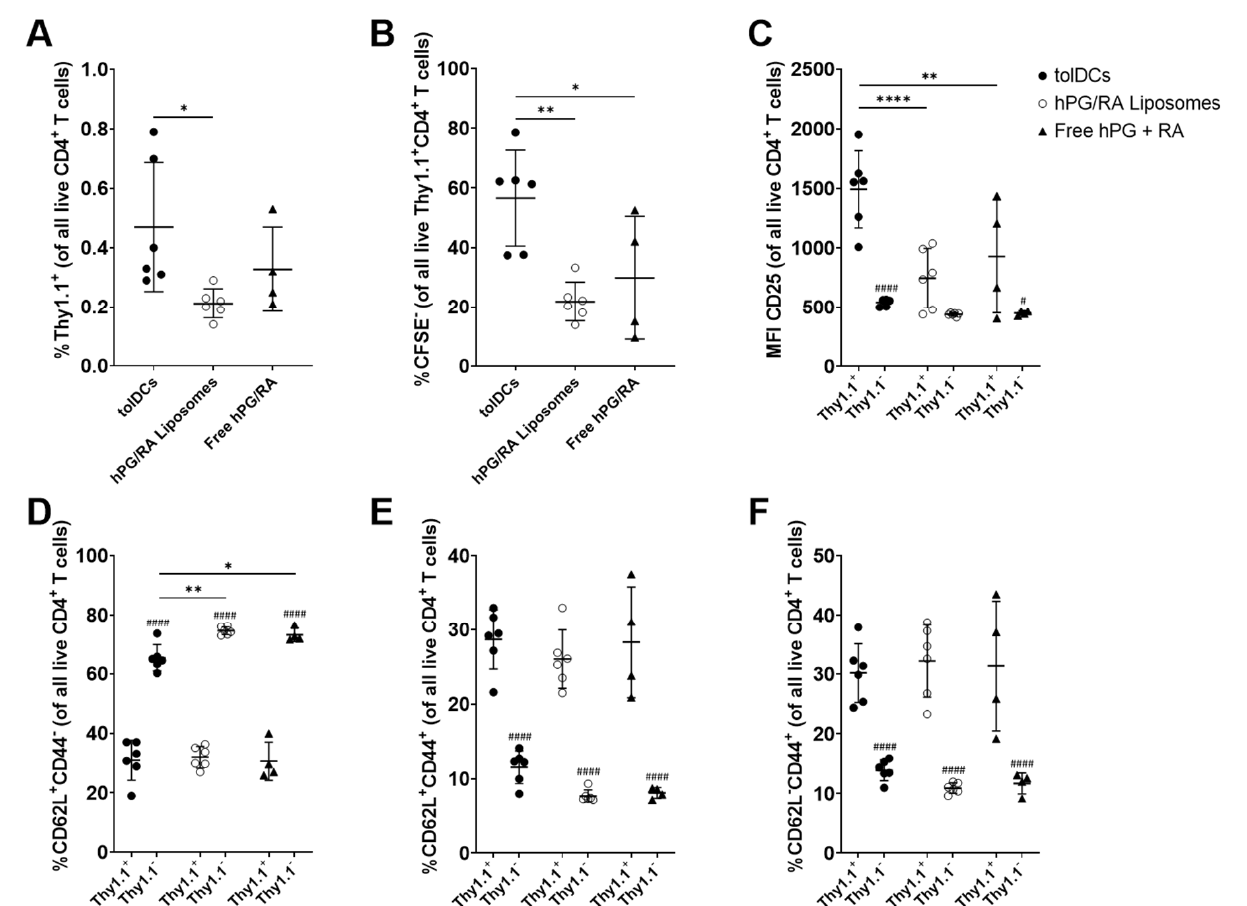
Figure 7. Effect of RA and hPG delivery on the activation of splenic CD4+ T cells in vivo. WT Balb/c mice received CFSE-labeled Thy1.1 + CD4 + CD25 − T cells isolated from the spleens of hPG-TCR transgenic mice via intravenous injection. 24 h after injection, mice received intravenous injections of either tolDCs pulsed with hPG and RA (tolDCs), liposomes encapsulating hPG and RA (hPG/RA Liposomes), or free hPG + RA. Three days after injection, splenic CD4 + T cells were assessed by flow cytometry. ( A ) % of antigen-specific Thy1.1 + CD4 + T cells, and ( B ) % of proliferated CFSE − cells within this population. ( C ) CD25 + , ( D ) naïve CD62L + CD44 − , ( E ) central memory CD62L + CD44 + , ( F ) and effector CD62L − CD44 + cells within the Thy1.1 + and Thy1.1 − CD4 + T cell populations. n = 6 for tolDCs and hPG/RA Liposomes, n = 4 for free